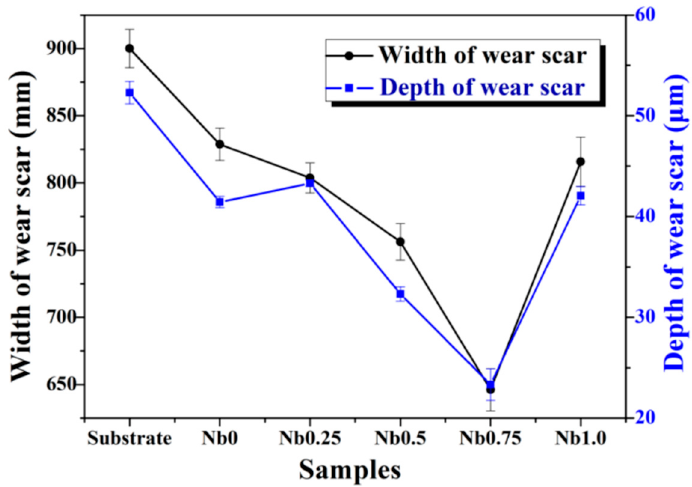
Figure 6. The wear scar width and depth of the substrate and the AlCoCrFeNiNb x (x = 0, 0.25, 0.5, 0.75, and 1.0) alloy coatings.